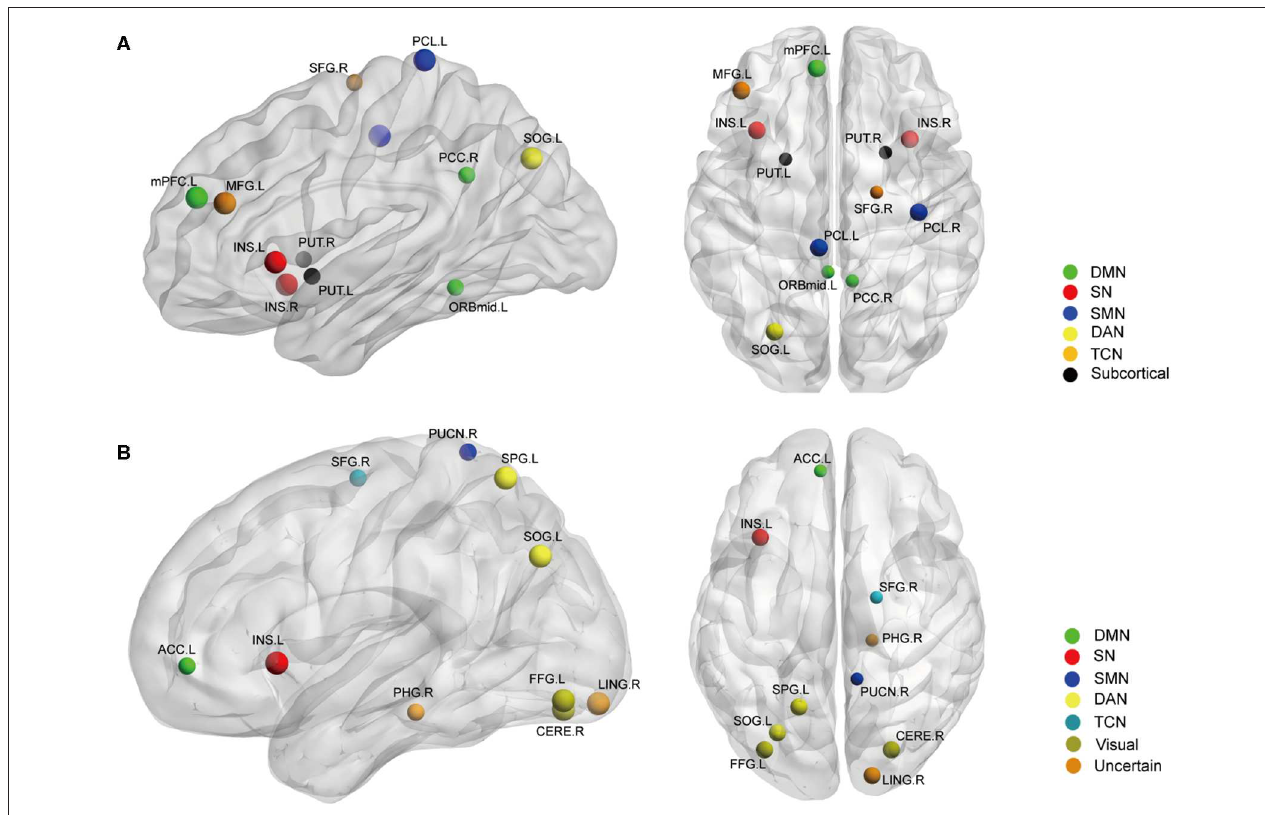
FIGURE 3 | The nodal BC (A) and DC (B) differences between AS patients and HC ( p < 0.05, FDR corrected). Ball color indicates different brain networks. Ball size indicates the difference direction (bigger ones: AS > HC, smaller ones: AS < HC). DMN, default mode network; SN, salience network; SMN, sensory/somatomotor network; DAN, dorsal attention network; TCN, fronto-parietal task control